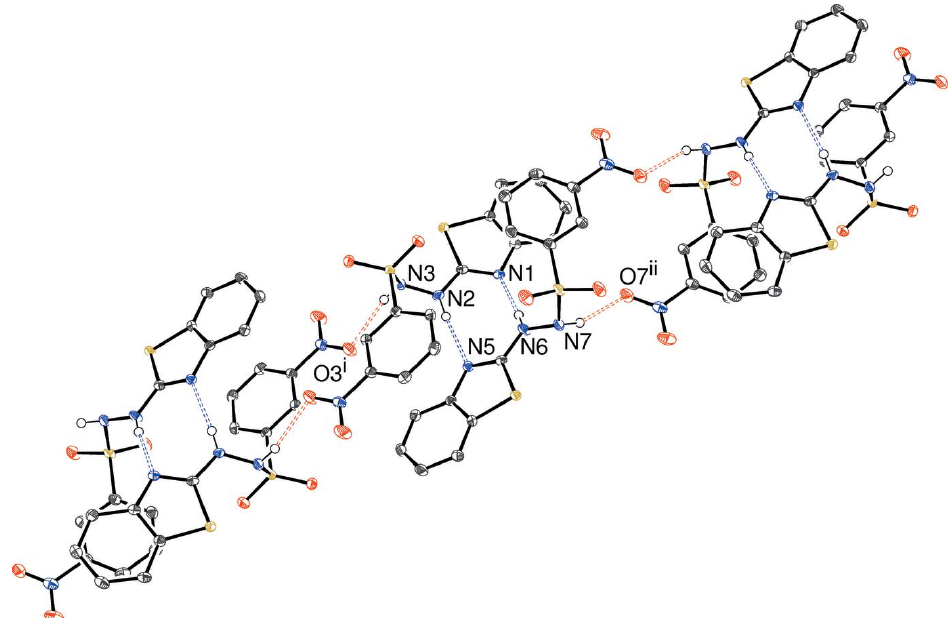
Figure 5 Fragment of a [111] hydrogen-bonded chain in (II) with the N—H (cid:2)(cid:2)(cid:2) N and N—H (cid:2)(cid:2)(cid:2) O bonds shown as blue and red double-dashed lines, respectively. All C-bonded hydrogen atoms have been omitted for clarity. Symmetry codes: (i) (cid:3) x , 1 (cid:3) y , (cid:3) z; (ii) 1 (cid:3) x , (cid:3) y , 1 (cid:3) z